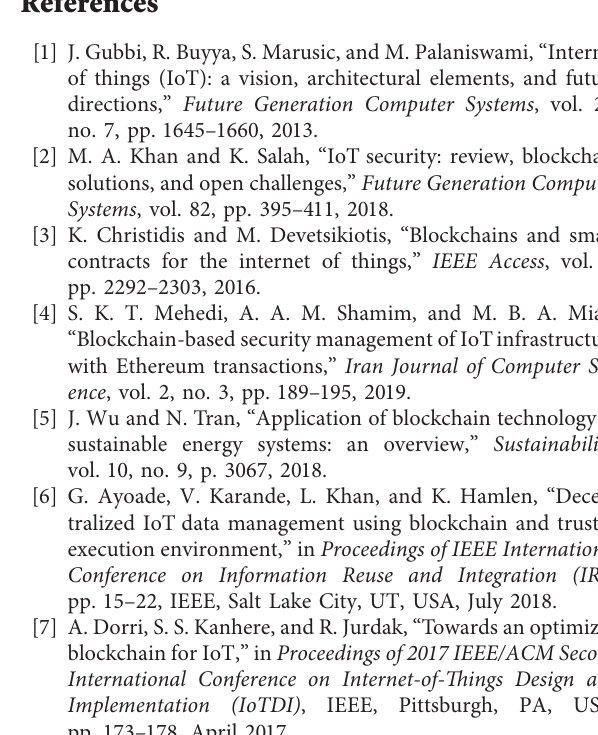
Figure 13: Throughput